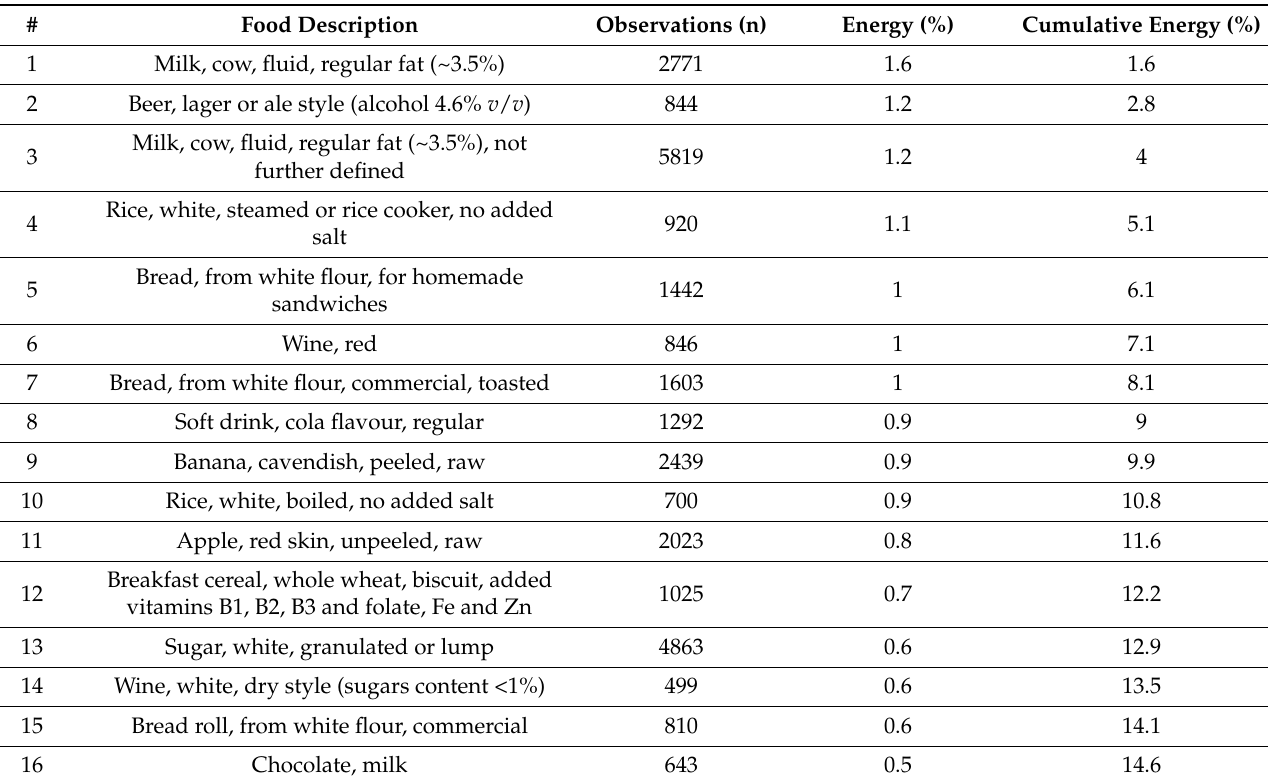
Table 2. The 100 most popular foods consumed in Australia by energy